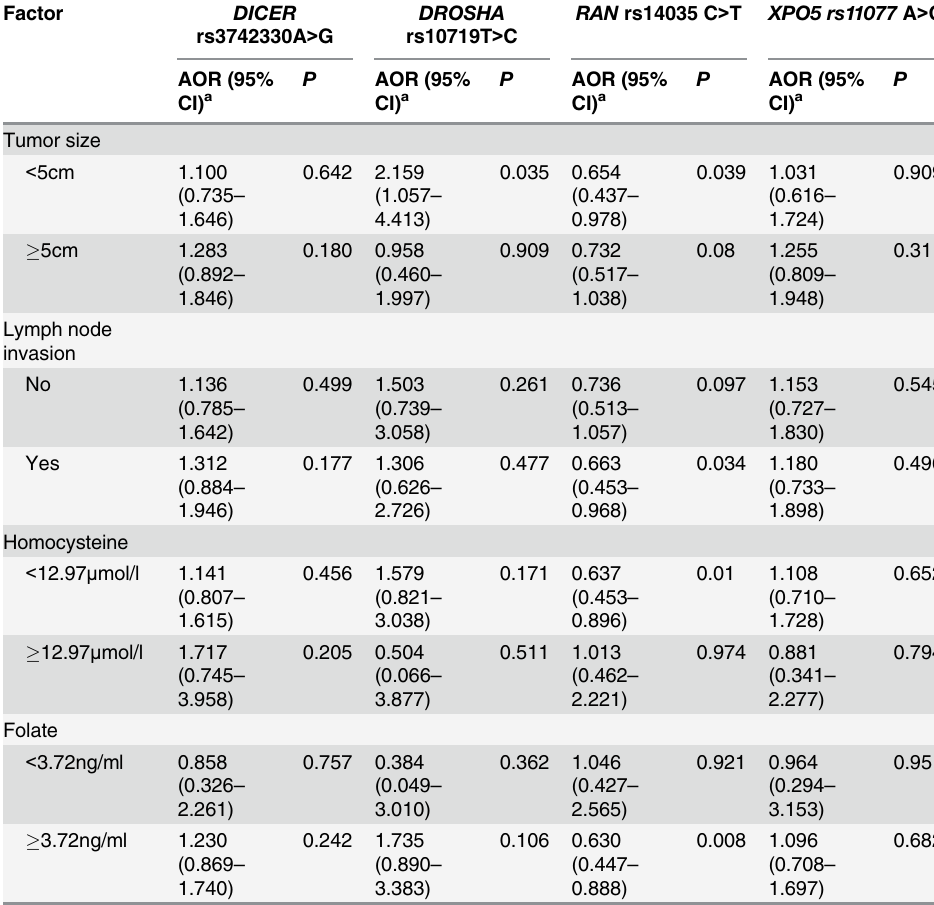
Table 7. Stratified effect of miRNA machinery gene polymorphisms on colorectal cancer risk